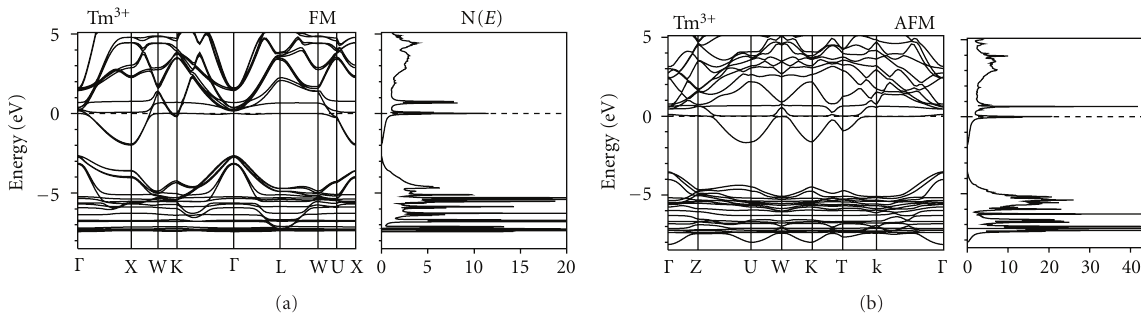
Figure 70: Self-consistent fully relativistic, spin-polarized energy band structure and total DOS (in states/(unit cell eV)) calculated for TmSe in ferromagnetic (FM) and antiferromagnetic (AFM) ordering